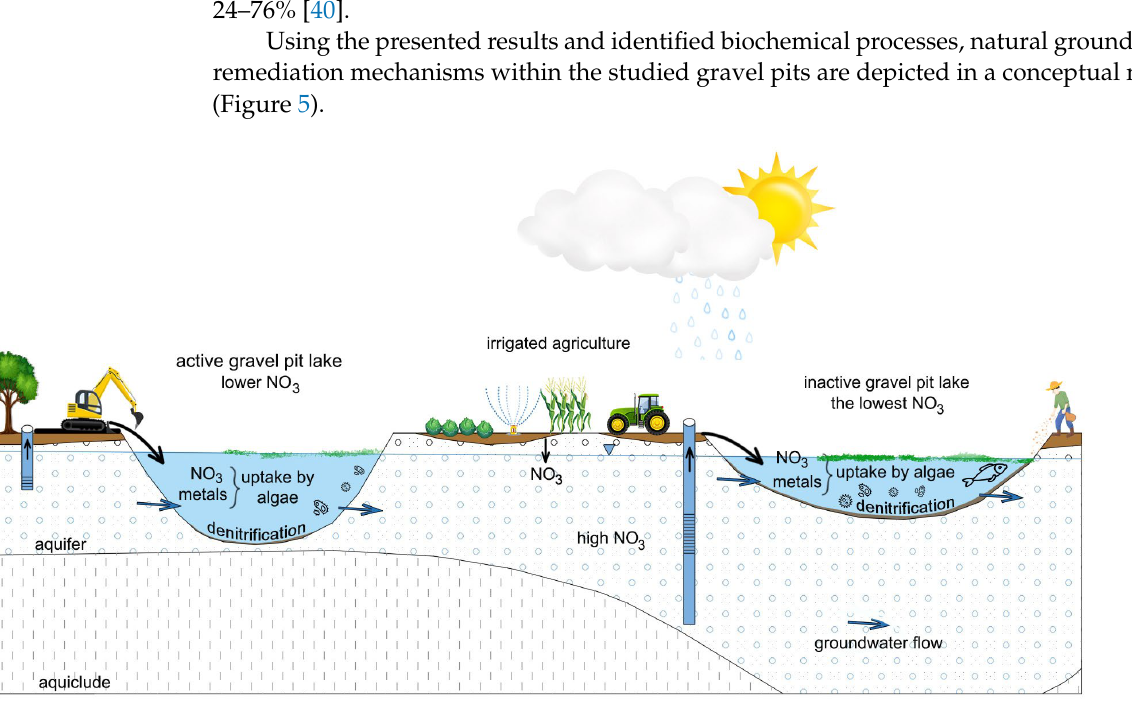
Figure 5. A conceptual model illustrating natural groundwater remediation processes observed in gravel pits surrounded by agricultural land. Nitrate-contaminated groundwater and surface wash- out recharges the gravel pit, where nitrate is reduced through uptake by algae in the summer period, combined with denitrification in the win ter period. The nitrate decrease is more pronounced in the